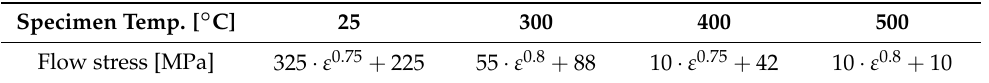
Table 1. The flow stress relation characterized for the examined Al6061 at different temperatures. Specimen Temp. [ ◦ C]